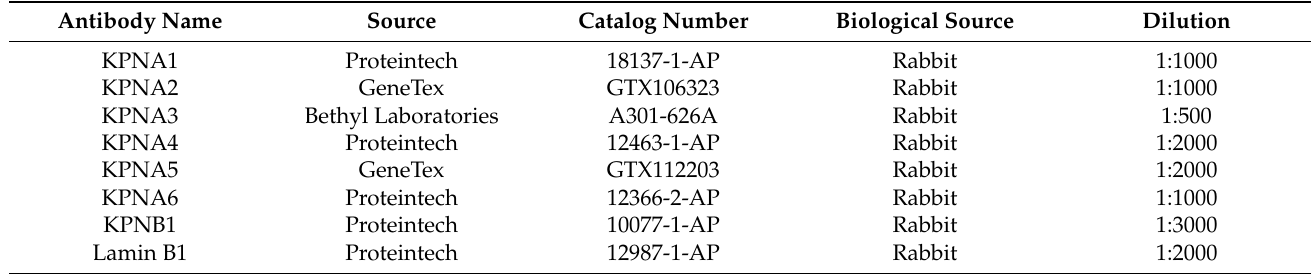
Table 2. Primary antibodies for Western